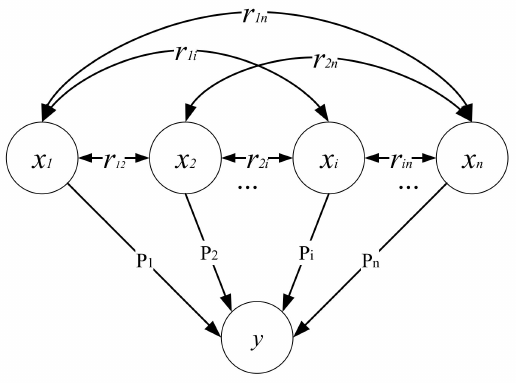
Figure 3. Path network diagram between